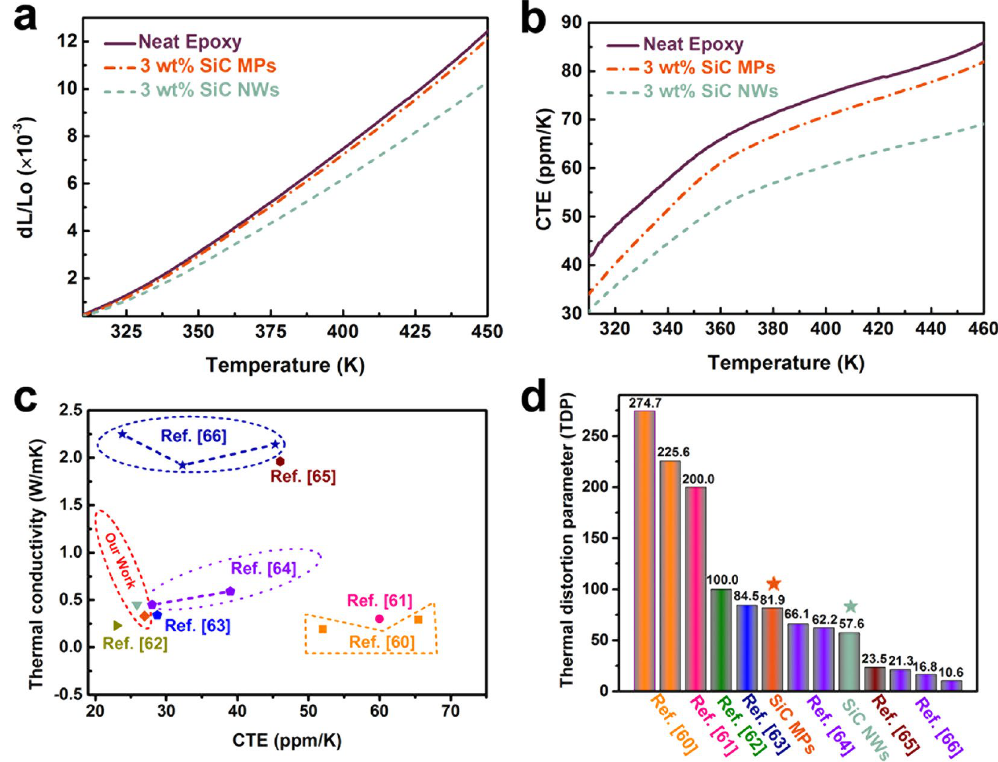
Figure 7. TMA curves of neat epoxy and epoxy composites: ( a ) thermal strain curves, ( b ) CTE curves; Comparison of ( c ) thermal conductivity versus CTE and ( d ) TDP of the epoxy/SiC NWs and epoxy/SiC MPs composites with various engineering